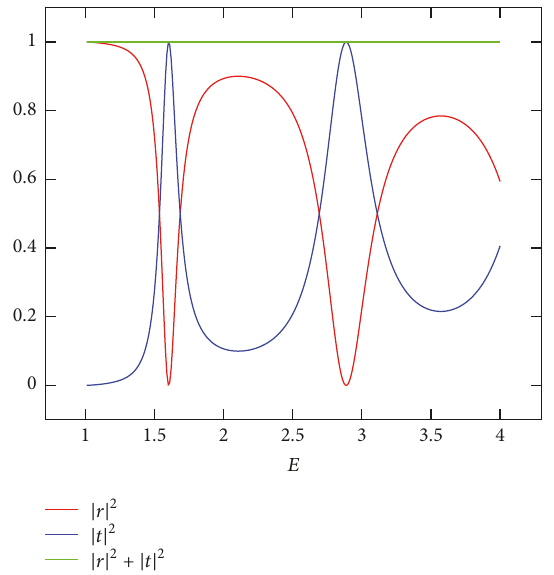
Figure 1: Treatments of the coefficients in terms of energy. For this plot, we have set 𝑚 = 𝑎 0 = 𝑉 푎 = 𝑉 푏 = 1 and energy ∈ [1,4]